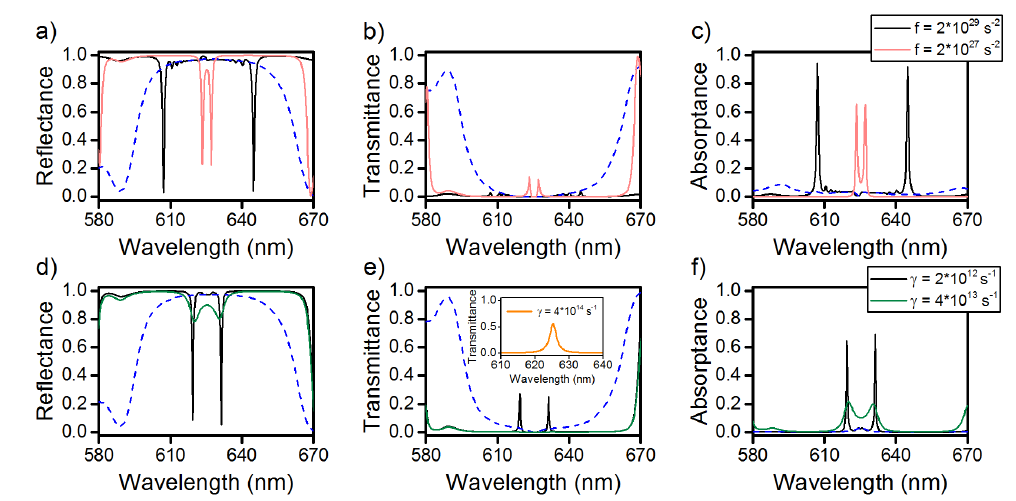
Figure 3. ( a , d ) Reflectance, ( b , e ) transmittance, and ( c , f ) absorptance spectra of the investigated structure at different volume concentrations of dye molecules and damping coefficients. Solid curves correspond to the diffracting polarization and the dashed curve, to the nondiffracting one. The rest parameters are the same as in Figure 2. The insert in figure ( e ) shows the transmission spectra of the structure for γ = 4 × 10 14 s − 1